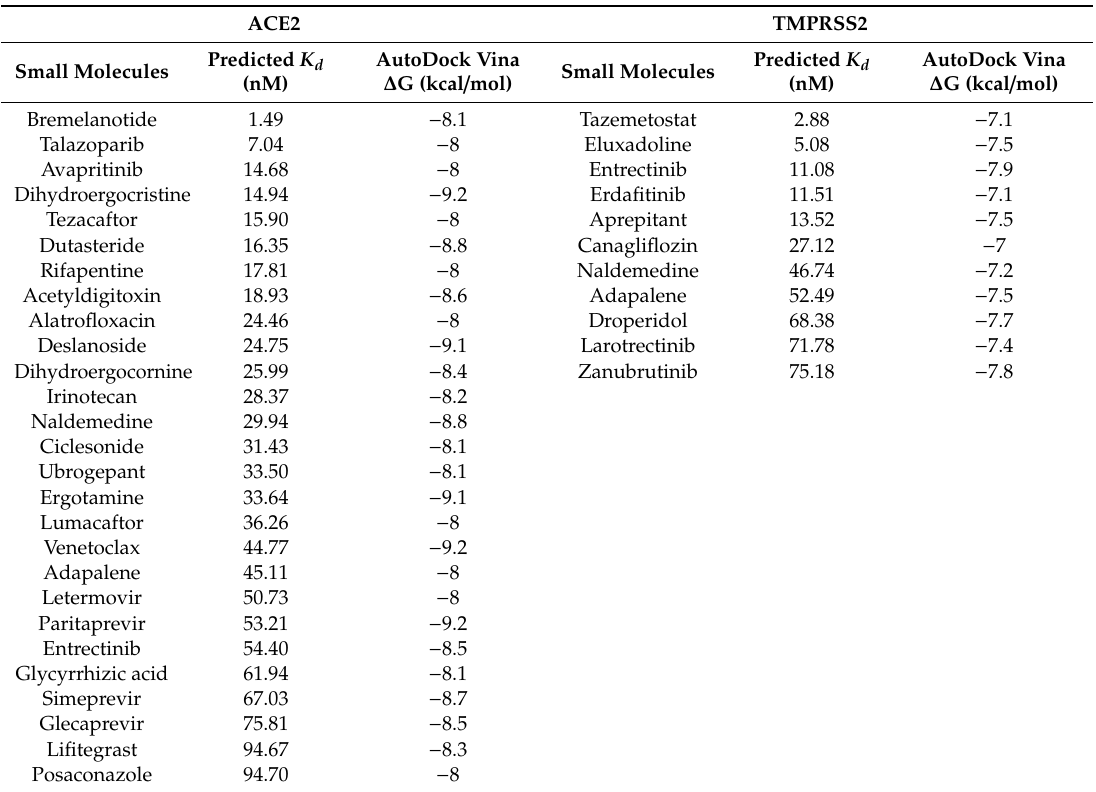
Table 3. Cross-prediction results of ACE2 and TMPRSS2 interacting drugs through MT-DTI and AutoDock